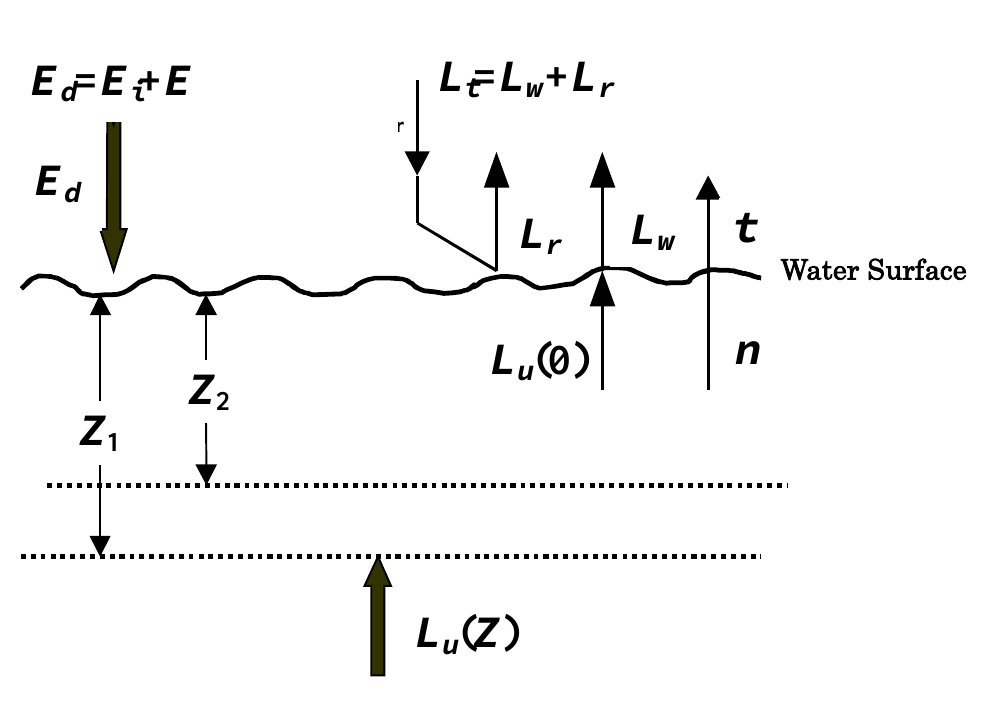
Figure 1 . Schematic diagram of an optical system above and below the water